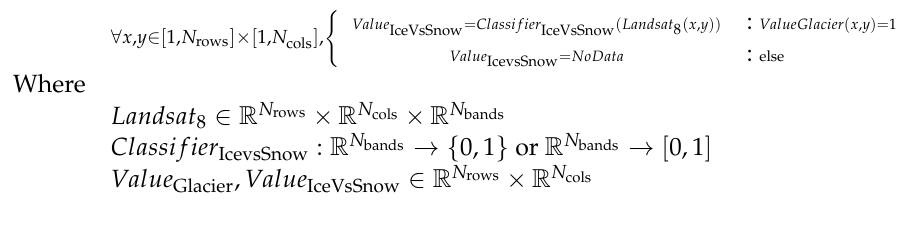
Table 4. Performance of the models used for the ice vs. snow detection task obtained from a random testing subset of the data set built for the ice and snow detection task (Table 2). Model